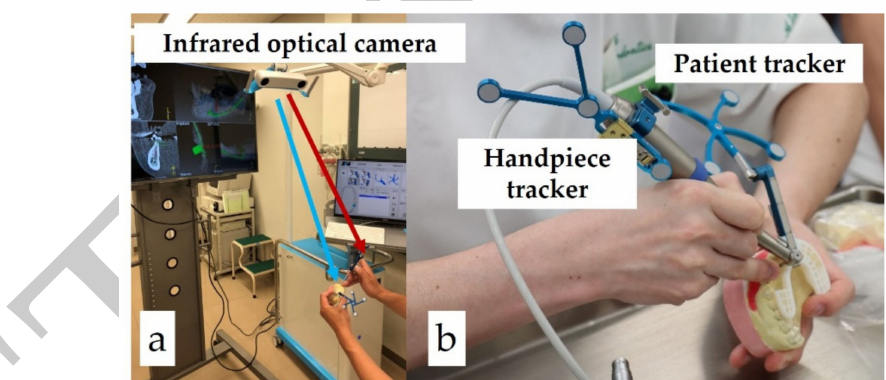
Figure 2. Preoperative procedure (calibration, virtual planning and simulation): ( a ) calibration of patient and handpiece tracker; ( b ) virtual planning and